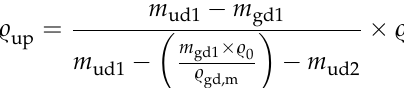
Figure 4. The curves of double conversion (DC) versus irradiation time of each dental resin system. Bis-GMA: 2,2-bis[4-(2-hydroxy-3-methacryloy-loxypropyl)-phenyl]propane; TEGDMA: triethyleneglycol dimethacrylate; FDMA: fluorinated dimethacrylate.